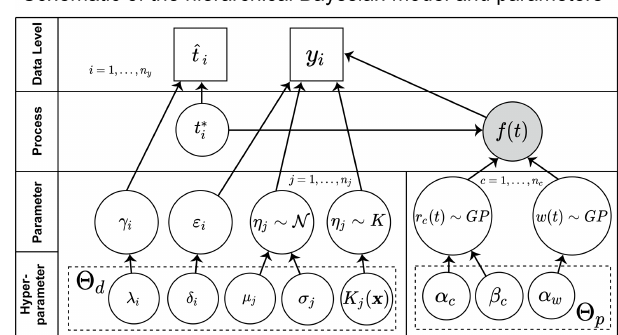
Figure 2. Directed acyclic graph of the Bayesian hierarchical framework of our model. Square nodes represent observed quanti- ties (data), and circular nodes represent unknown quantities (latent variables and model parameters), where the gray circle represents the ultimate variable of interest to be modeled. Arrows indicate con- ditionality. Each node in the graph is conditionally independent of all others, given the parameters in the previous level. Variables and conditional distributions are specified in the main text. The hyperpa- rameters are represented in the lowest level, where x represents the data used in the data-fitting process, and K represents the nonpara- metric empirical distribution (kernel density function). Parameters of the models in the middle level are controlled by the hyperparam- eters in the bottom level. The (hyper)parameters on the left (right) represent the data (process) model. Unobserved (latent) variables t ∗ and f ( t ) are represented in the process level, such that the data level represents the only observed quantities in the model. Posterior esti- mates of the parameter distributions contribute to the process uncer- tainty in the model, and sea levels over time can be estimated from distributions of the data and parameters. The Bayesian nature of the framework allows for the inversion of the conditional distributions resulting in the posterior distribution f ( t ), the final model output. Further details of each level and the parameters involved may be found in the